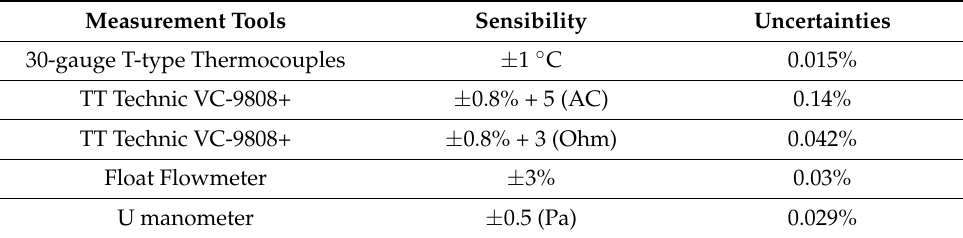
Table 4. Features and sensitivities of the measuring